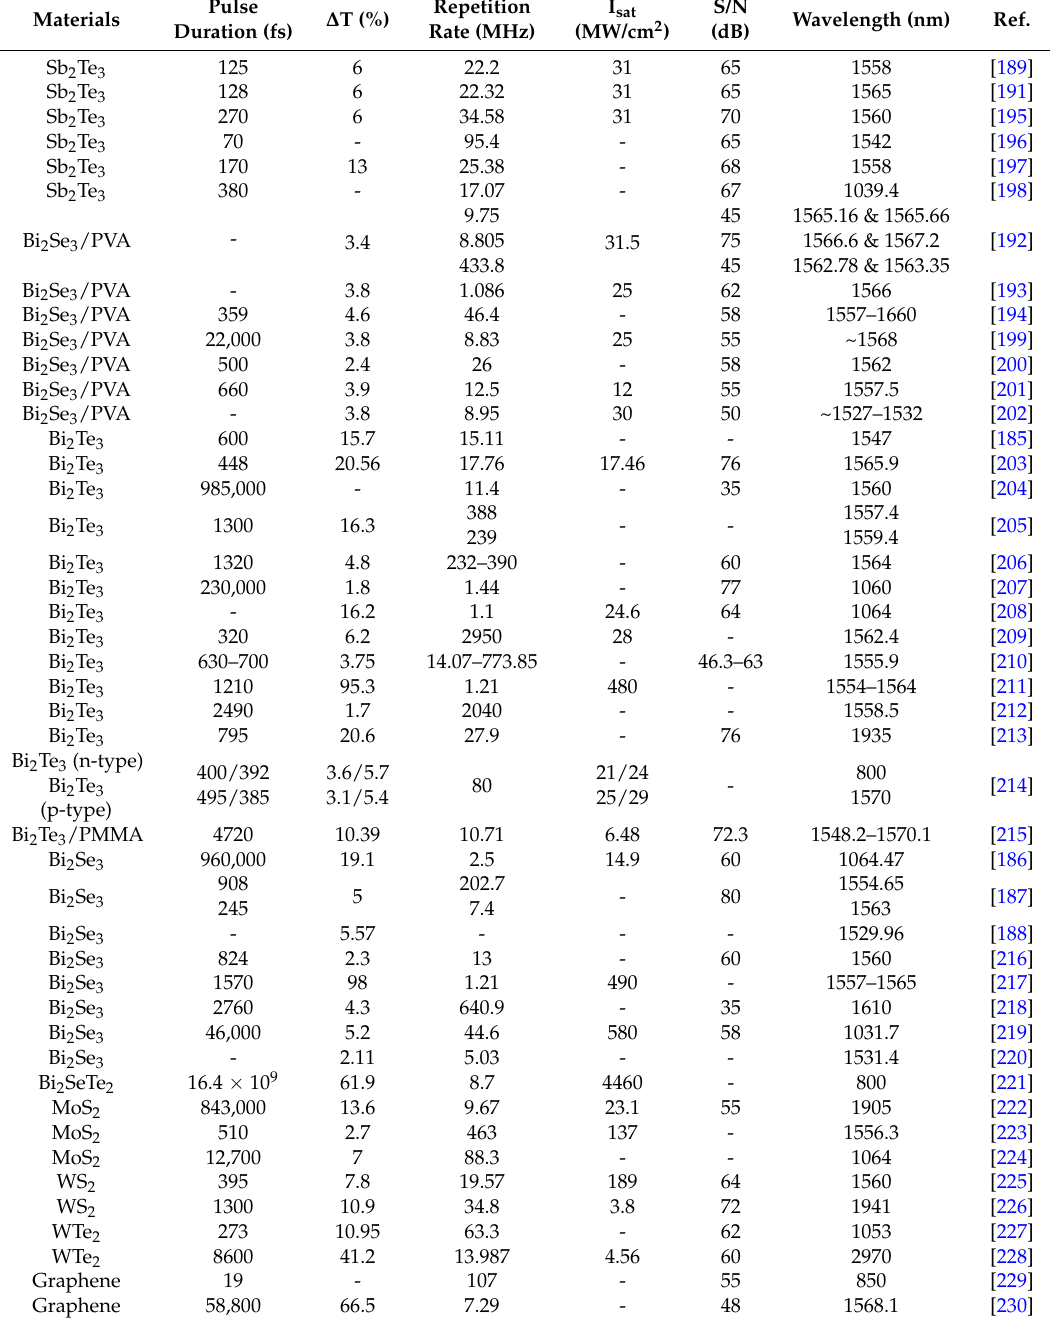
Table 6. Different mode-locked fiber lasers based on TIs and some normal